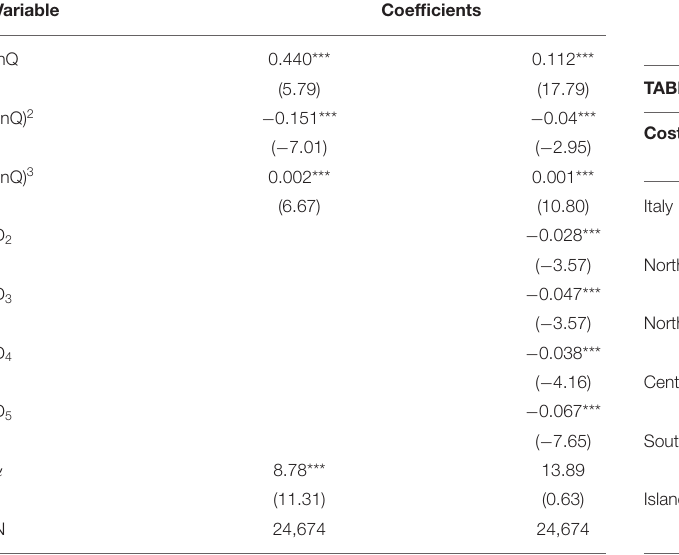
TABLE 4 | Results of estimating the waste recycling cost